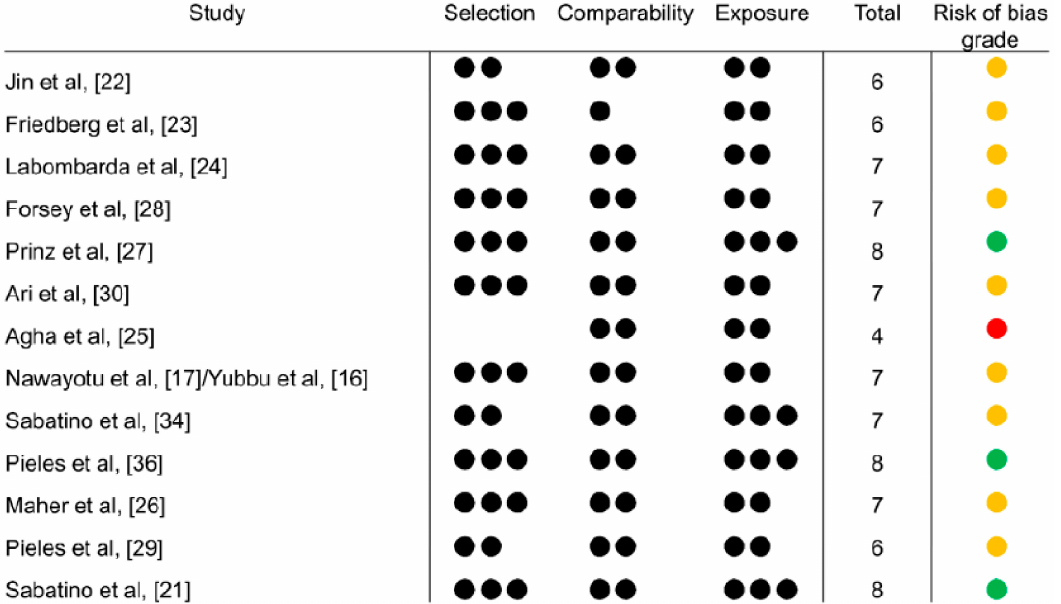
Figure 5. Newcastle Ottawa scale risk of bias evaluation results. Total maximum is 9 points, Selection is 3 points, Comparability is 2 points and Exposure is 4 points. Semi qualitative subjective risk of bias grading is green for low risk, orange for some concerns and red for high